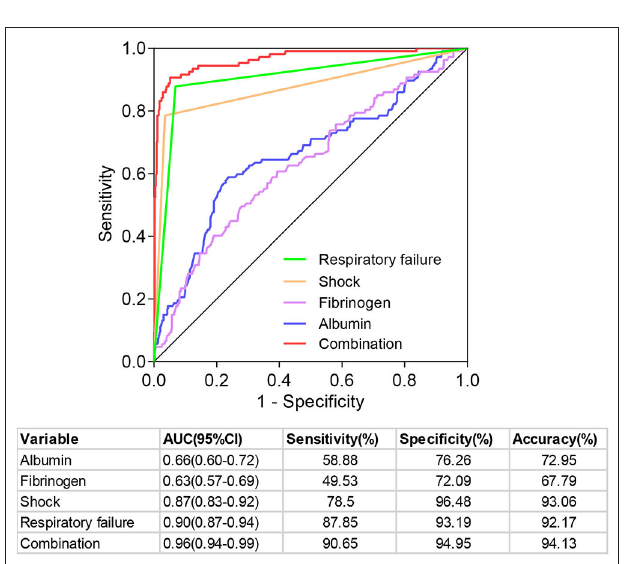
FIGURE 3 | Predictive value of different prognostic indicators in predicting the prognosis of patients with bloodstream